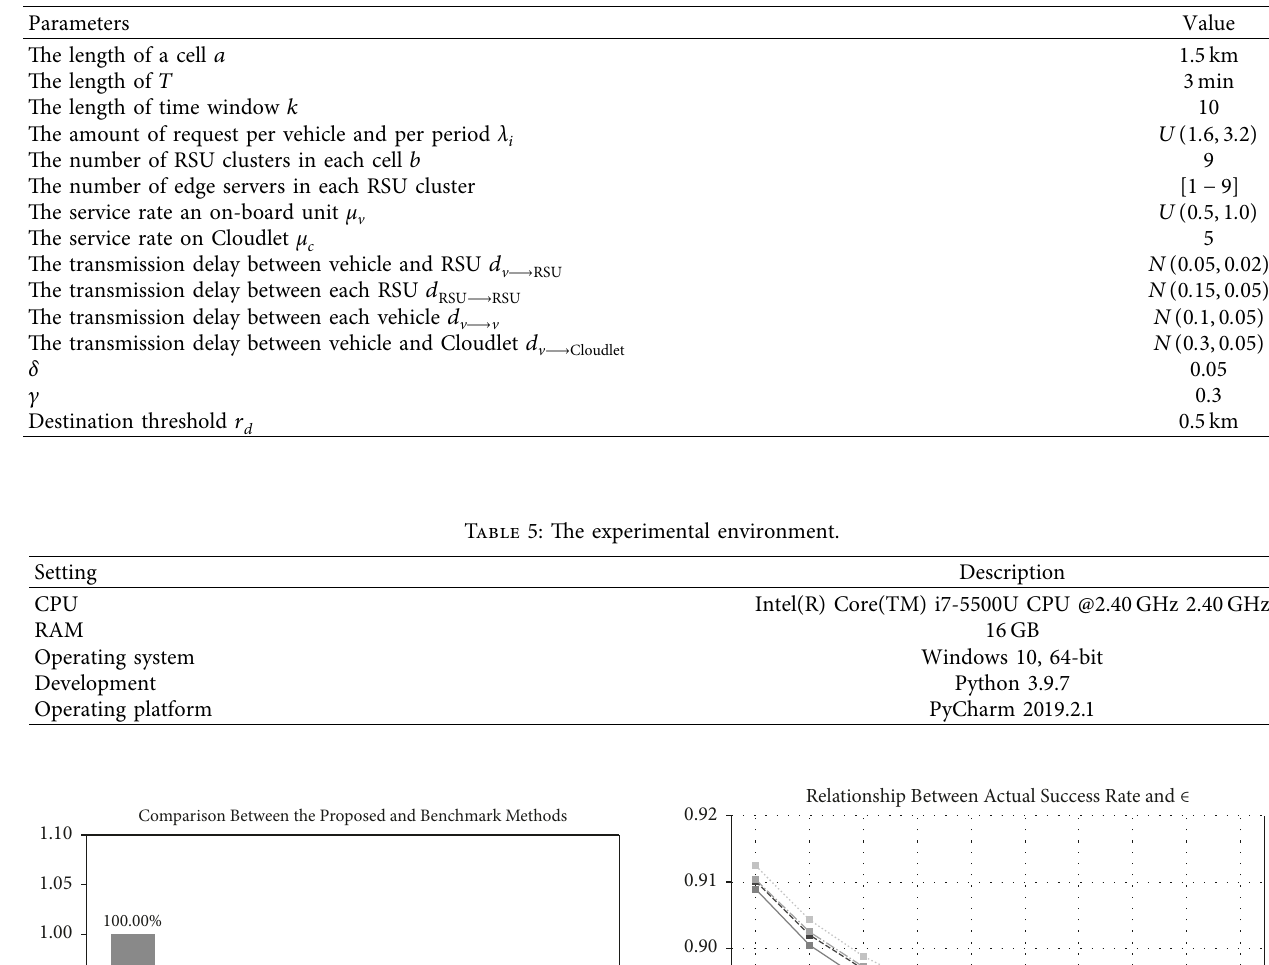
Table 4: Settings of the dataset and parameters.